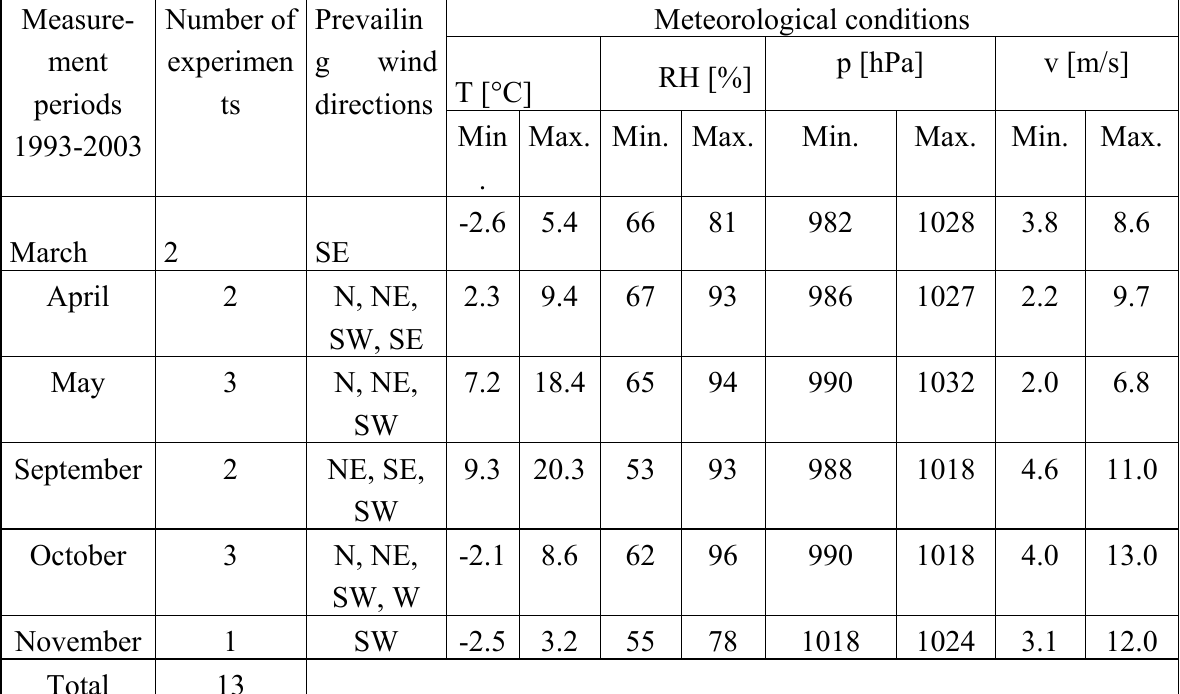
Table 1. Description of meteorological parameters registered during the measurement sessions in the Baltic area over a period